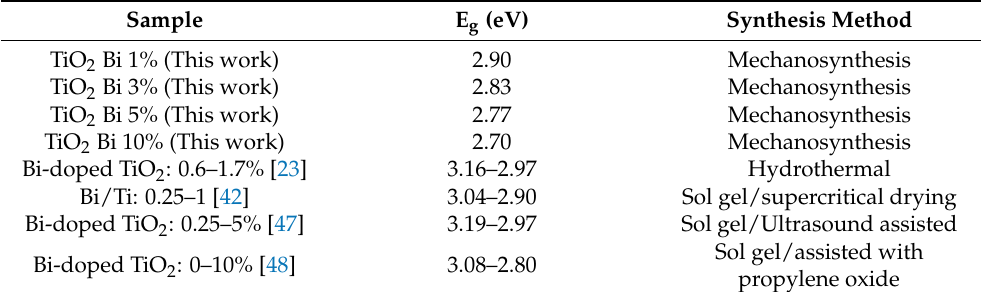
Table 3. E g values of Bi-doped TiO 2 samples obtained by mechanosynthesis compared with the reported values in the literature for Bi-doped TiO 2 samples obtained with other